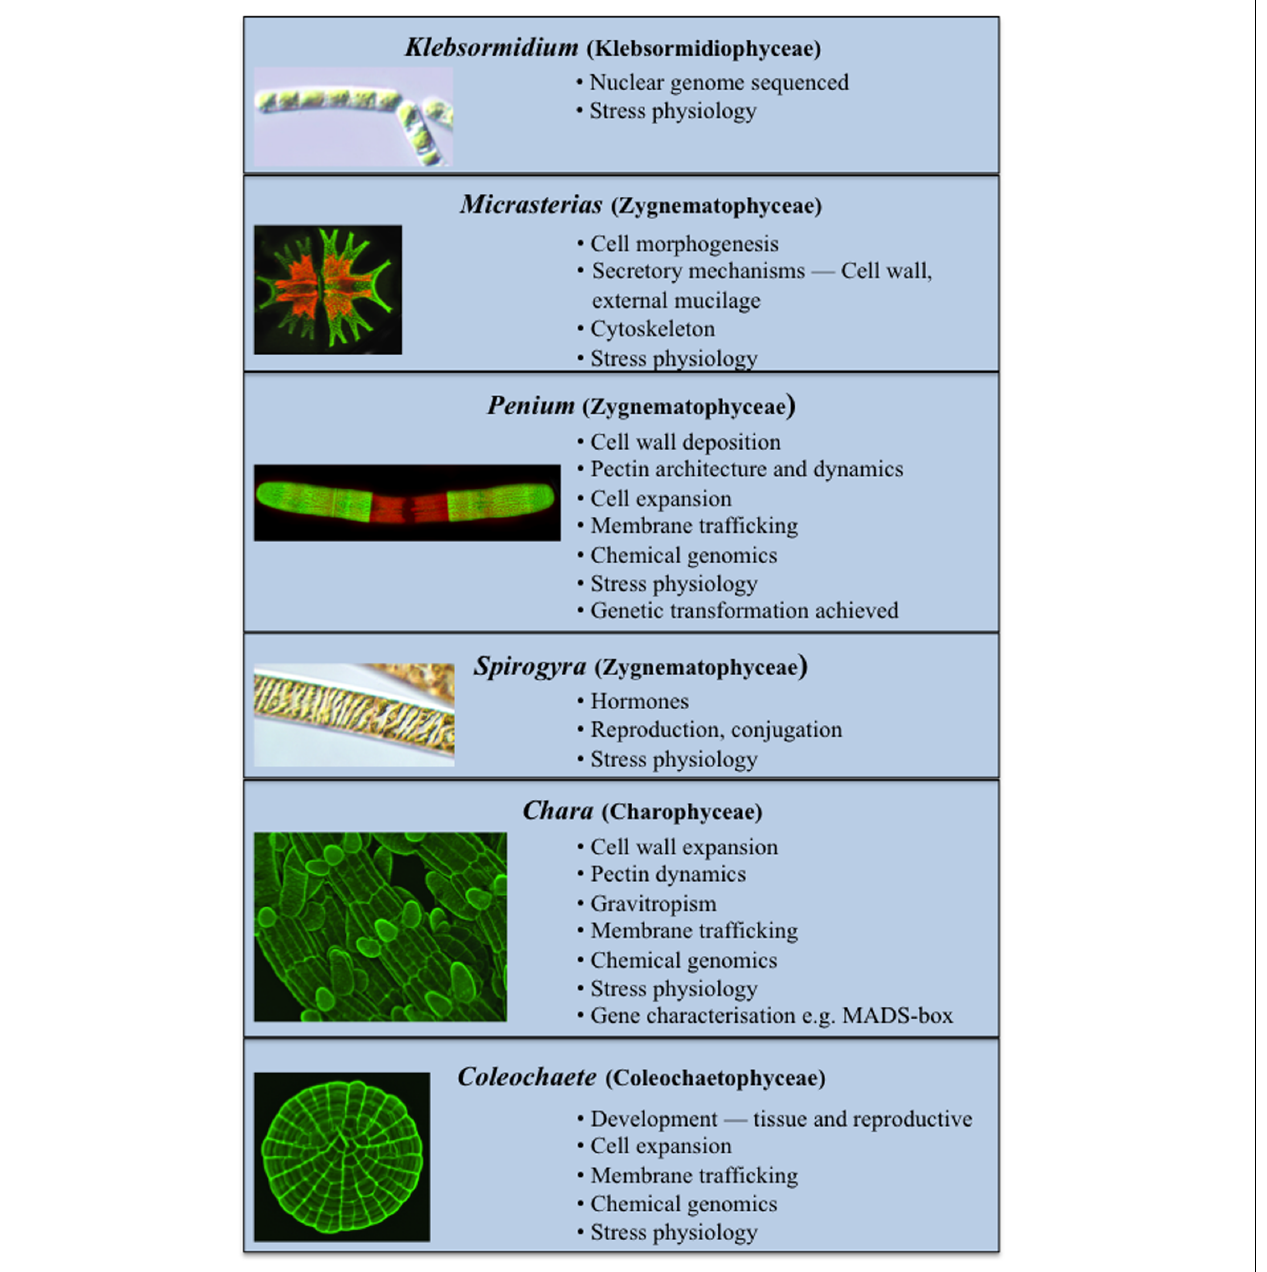
FIGURE 2 | Current model Charophytes. Several Charophytes including Klebsormidium, Micrasterias , Penium , Spirogyra , Chara, and Coleochaete are used as models; each has specific attributes that make it a particularly suitable model for specific physiological and biochemical